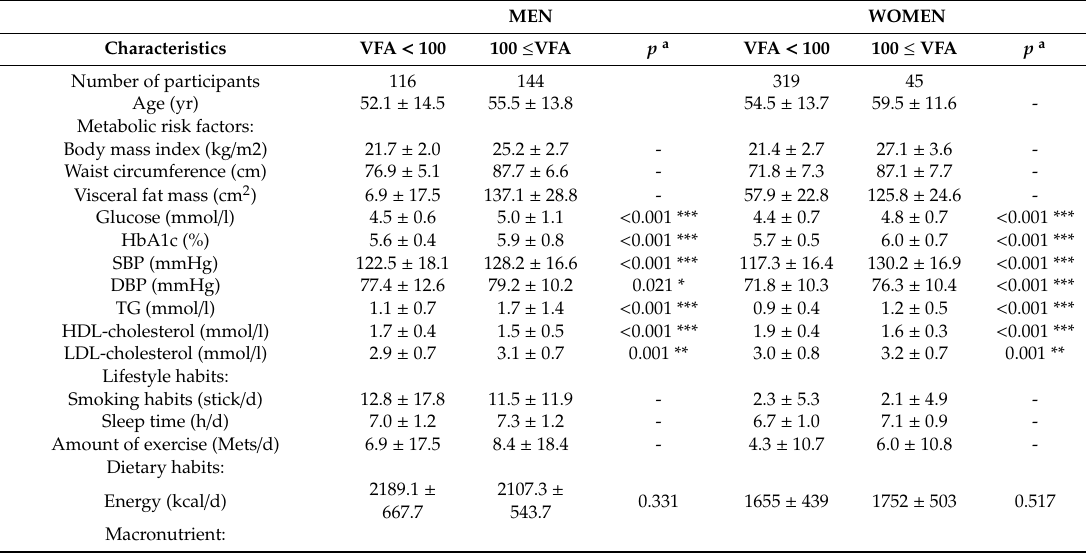
Table 1. Baseline participants’ characteristics based on the cut-o ff point of visceral obesity.